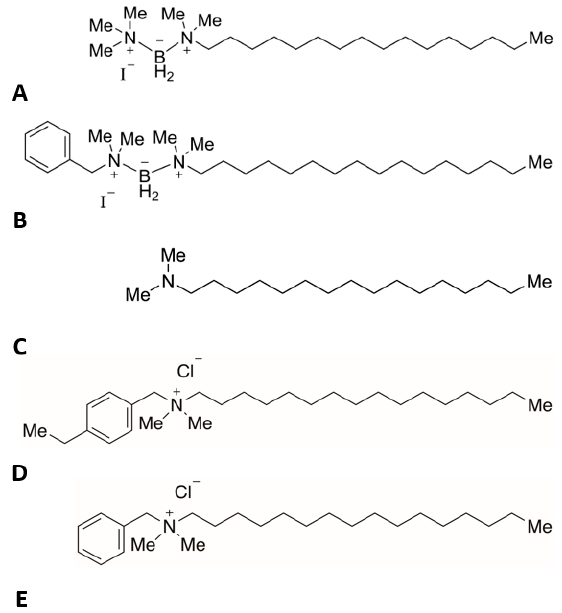
Figure 1. Test articles. Chemical structures of ( A )—boronium salt without benzyl group (C 21 H 50 BIN 2 ), ( B )—boronium salt with benzyl group (C 27 H 54 BIN 2 ), ( C )—N,N-dimethylhexadecylamine, a negative control without boronium ion (C 18 H 39 N), ( D )—alkyl dimethyl ethylbenzyl ammonium chloride (C 27 H 50 ClN), ( E )—alkyl dimethyl benzyl ammonium chloride (C 25 H 46 ClN). Structures D and E are similar to those found in the Bacdown disinfectant, which acted as a positive control (C16 structures are